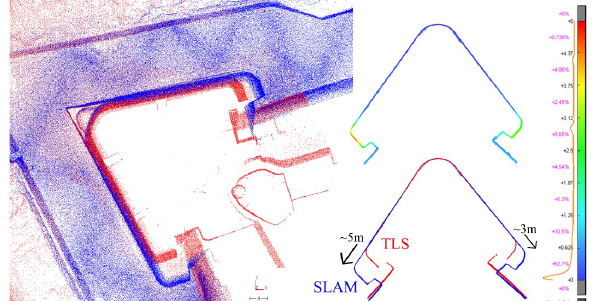
Figure 16. Detection of the drift error in the moat scan (Area1) around the south-western bastion. From the deviation analysis the bigger distance is up to 5m